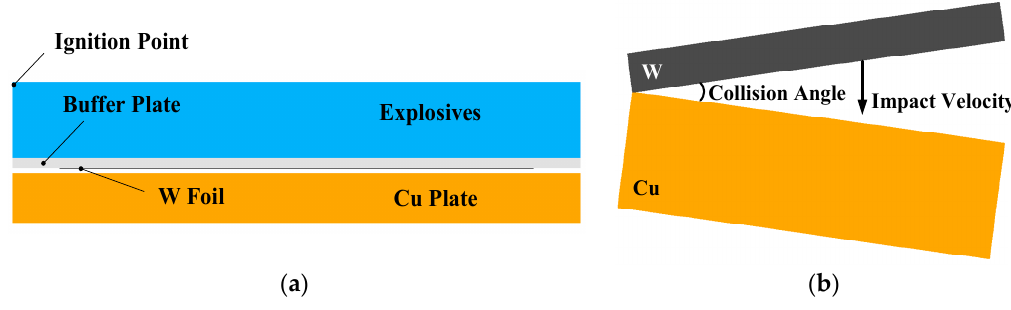
Figure 3. Schematic of Smoothed Particle Hydrodynamics (SPH) models: ( a ) the first stage; ( b ) the second stage.